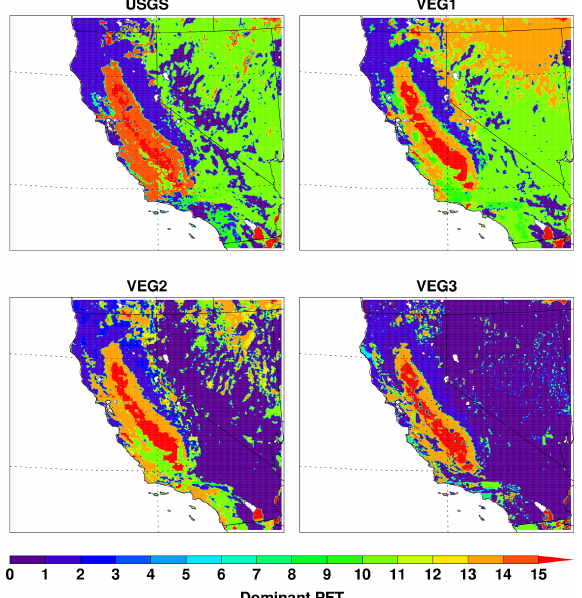
Figure 3. Spatial distribution of percentage of the four PFTs from the VEG-M used by MEGAN v2.0 over the simulation